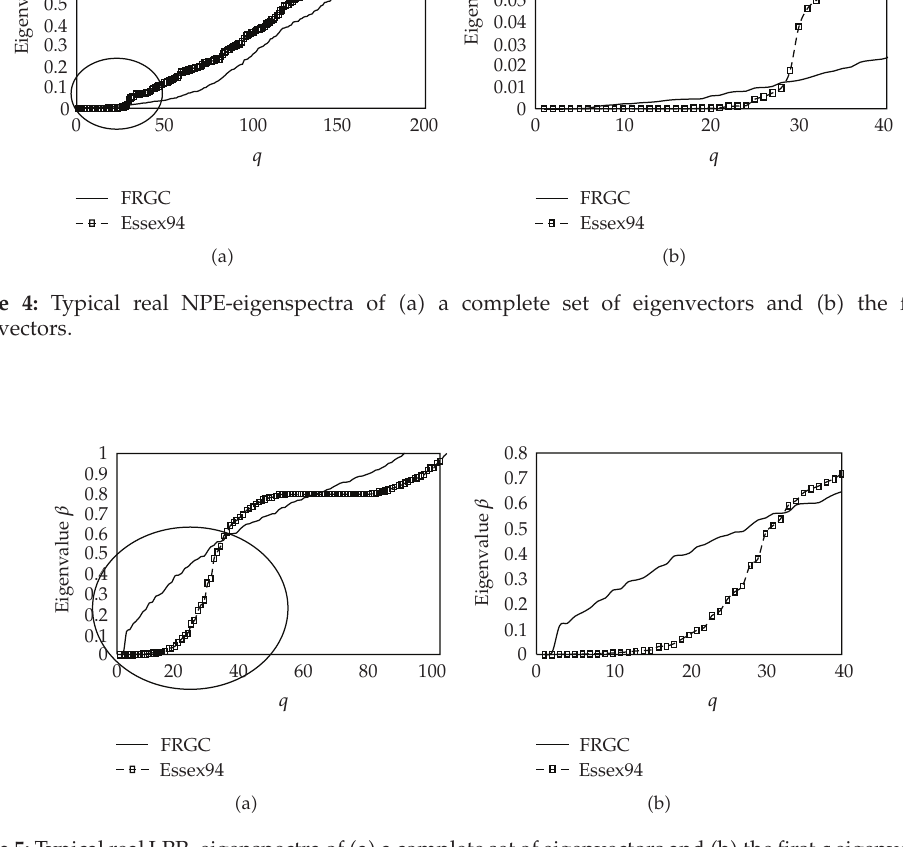
Figure 5: Typical real LPP- eigenspectra of (cid:2) a (cid:3) a complete set of eigenvectors and (cid:2) b (cid:3) the first q eigenvectors.